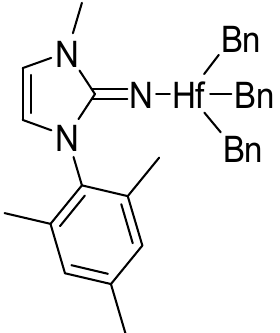
Figure 3. Schematic drawing of the asymmetric complex, imidazolin Mes,Me -2-iminato hafnium.